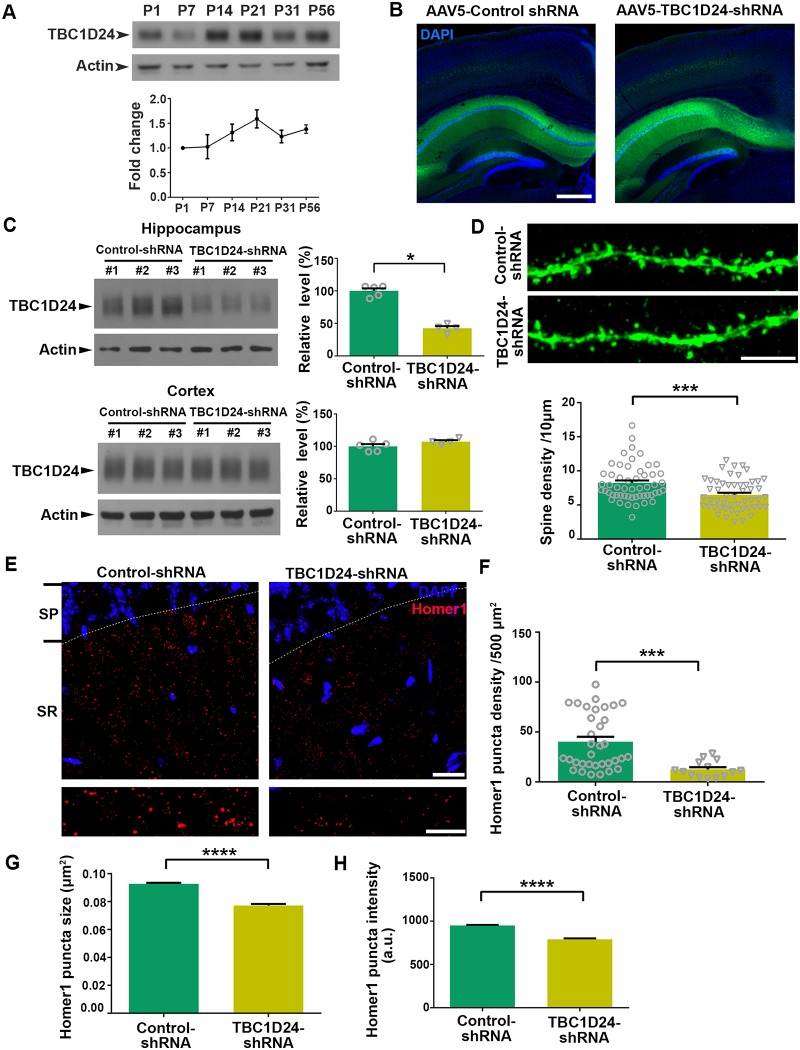
Knockdown of TBC1D24 in adult hippocampus results in reduction of dendritic spine density and affects Homer1 puncta in vivo.(A) The expression of TBC1D24 increased along postnatal development of the hippocampus. Results were pooled from three independent experiments. (B) Representative images of hippocampus injected with AAV5 carrying YFP and the corresponding shRNAs. Scale bar: 500 μm. (C) Western blot analysis showing the spatially-restricted knockdown of TBC1D24 after injection of AAV5 carrying control shRNA or TBC1D24-shRNA into the hippocampus. Significant reduction of TBC1D24 expression was observed in the hippocampus one month post-injection with TBC1D24-shRNA, while TBC1D24 expression in the cortex was not affected (n = 4–5 for each condition; mean+SEM; *p<0.05; Mann-Whitney test). (D) Representative images of hippocampal CA1 secondary apical dendrites of mice (12 weeks old) after injection of AAV carrying YFP and the corresponding shRNAs. Knockdown of TBC1D24 significantly decreased the number of dendritic spines in hippocampal CA1 neurons (52–53 dendrites from 5 mice were quantified for each condition; mean+SEM; ***p<0.001; Mann-Whitney test). Scale bar: 5 μm. (E) Hippocampal slices from mice (12 weeks old) injected with control or TBC1D24-shRNA were immunostained with anti-Homer1 antibody. Representative images of Homer1 puncta in the stratum radiatum (SR) of hippocampus CA1 region. SP = stratum pyramidae. Scale bars: 20 μm (top) and 10 μm (bottom). (F-H) The puncta density, size and intensity of Homer1 were significantly decreased in the hippocampus of mice administrated with TBC1D24-shRNA (14–34 images from 5 mice for each condition; mean+SEM; ***p<0.001; Mann-Whitney test in (F); 7119–37789 puncta were analyzed for each condition; mean+SEM; ****p<0.0001; Mann-Whitney test).